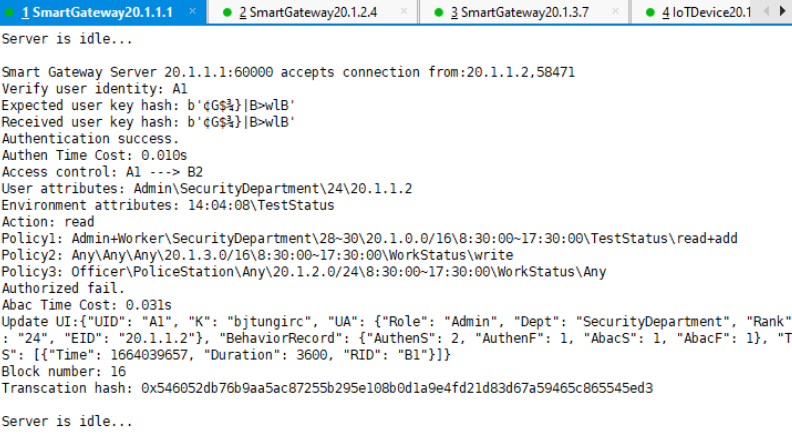
Figure 11. SG A performs access control process and the result is authorization failure.